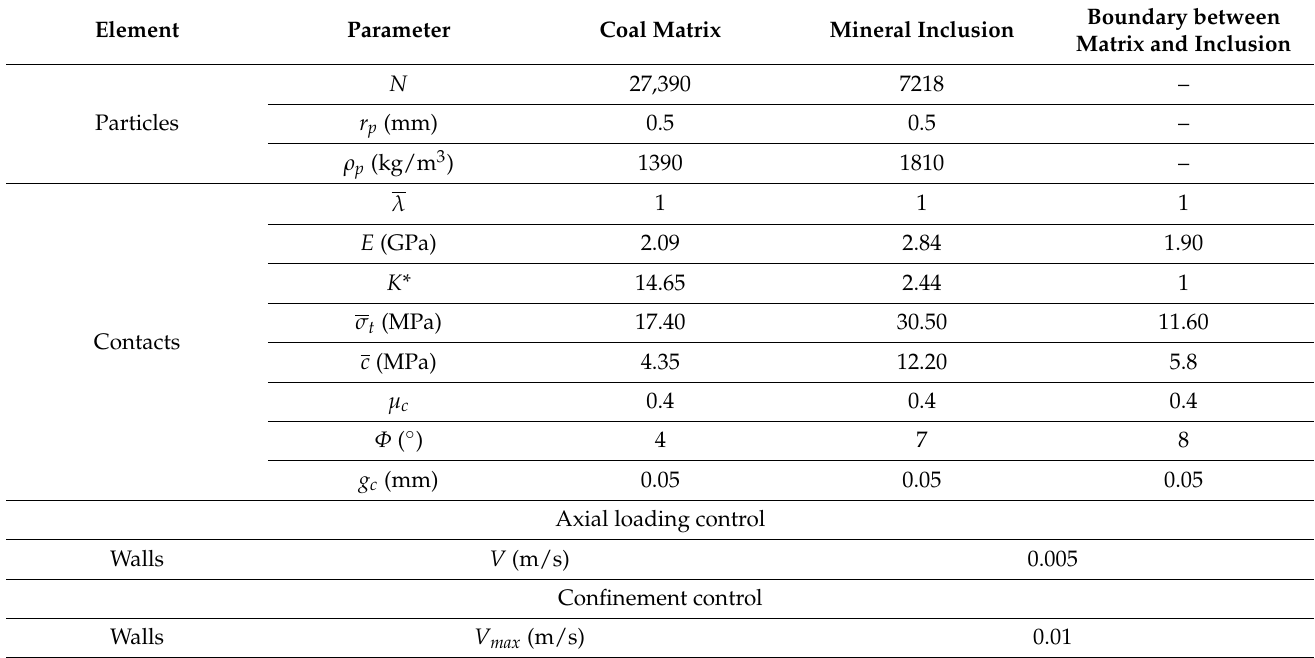
Table 2. Micro-mechanical parameters of the numerical coal model